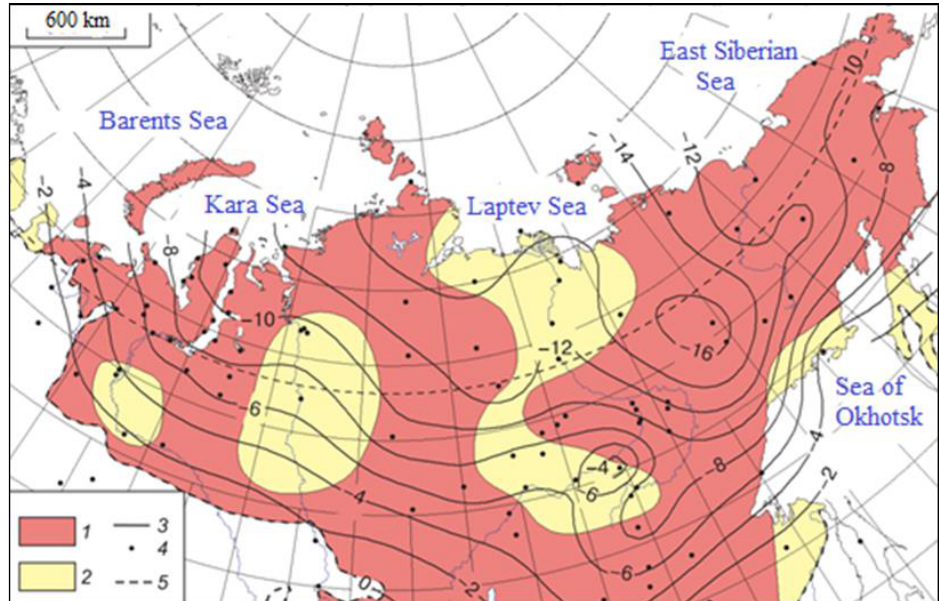
Figure 1. Mean annual air temperature variations in northern Russia for 2000–2010. 1, 2 = large (1) and moderate (2) warming relative to climate norm (Δ t air ), >1 °C and 0.7 °C to 1.0 °C, respectively; 3 = climate norm contour lines; 4 = weather stations; 5 = southern limits of permafrost, after [3] Malkova et al. 2010.